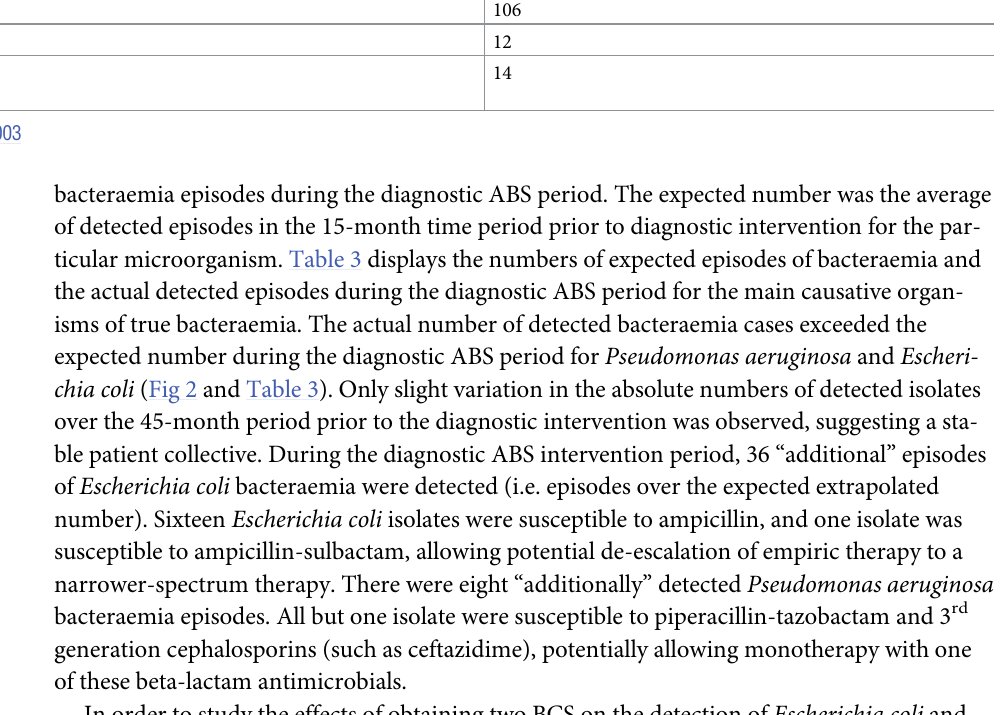
Table 3. Additionally detected microorganisms during the 15-month diagnostic ABS intervention period. Microorganism Expected number of episodes during the diagnostic ABS intervention period (average number of detected episodes in the pre-diagnostic ABS intervention period)